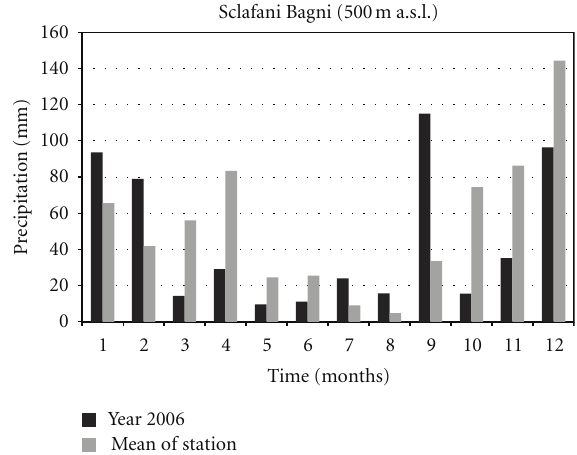
Figure 2: Monthly rainfall trend in 2006 compared with the mean trend registered in the thermopluviometric station.